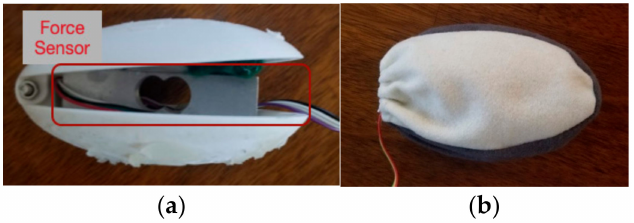
Figure 1. Prototype of Touch System’s Input Device. ( a ) Inside view of device; ( b ) Outside view of